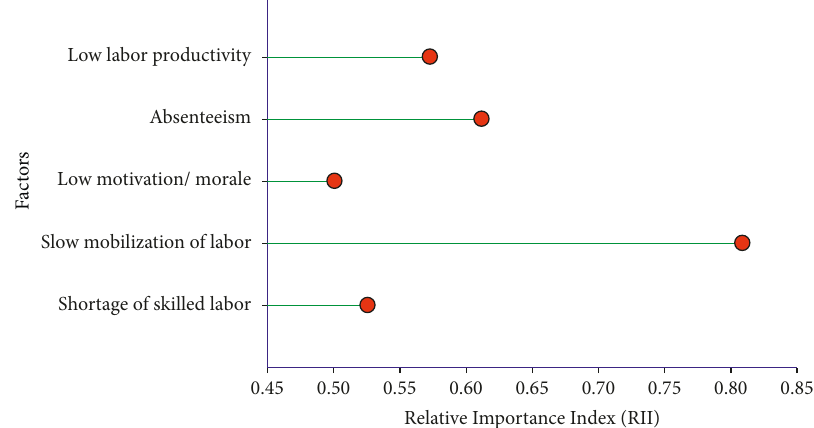
Figure 5: Ranking of labor-related factors.